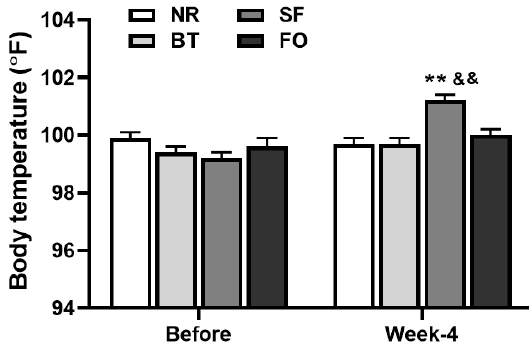
Figure 3. Comparison of body (rectal) temperature of rats before and after different diet feeding for 4 weeks. Values are expressed as mean ± SE.; n = 6, ** p < 0.01 vs. safflower oil (SF) rats before the diet feeding, and && p < 0.01 vs. the rats in other 3 groups at the same time point.